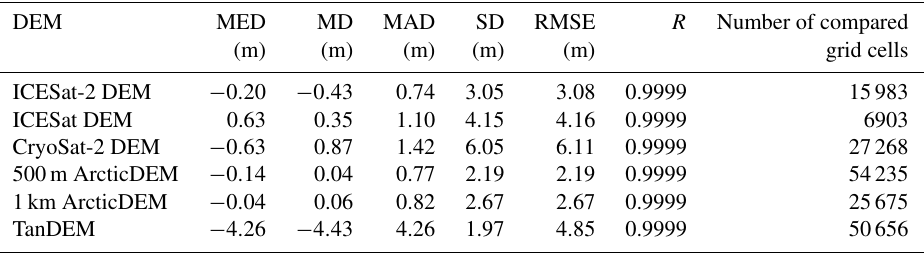
Table 6. Elevation differences of the ICESat-2 DEM and other published DEMs with respect to IceBridge data in the regions which have little elevation change rate ( − 0 . 05–0.05myr − 1